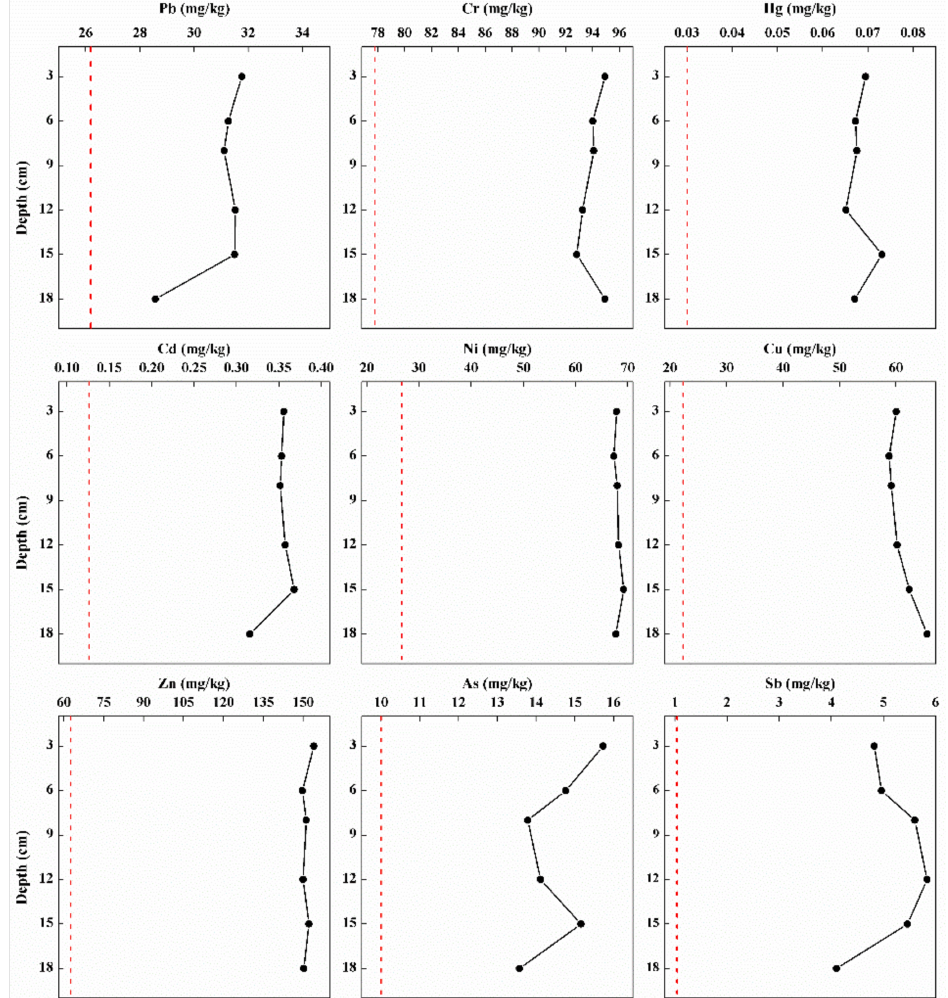
Figure 3. The vertical distributions of heavy metals in the sediment with an increase in depth. Red lines indicated the background baselines for each heavy